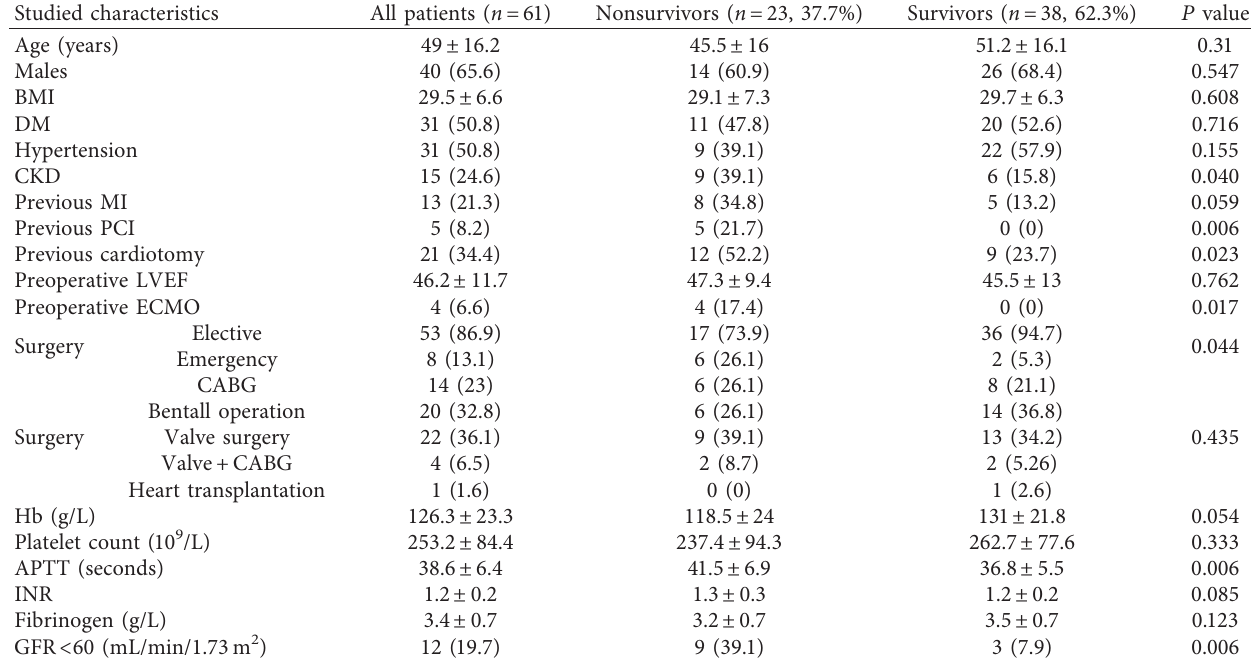
Table 1: baseline